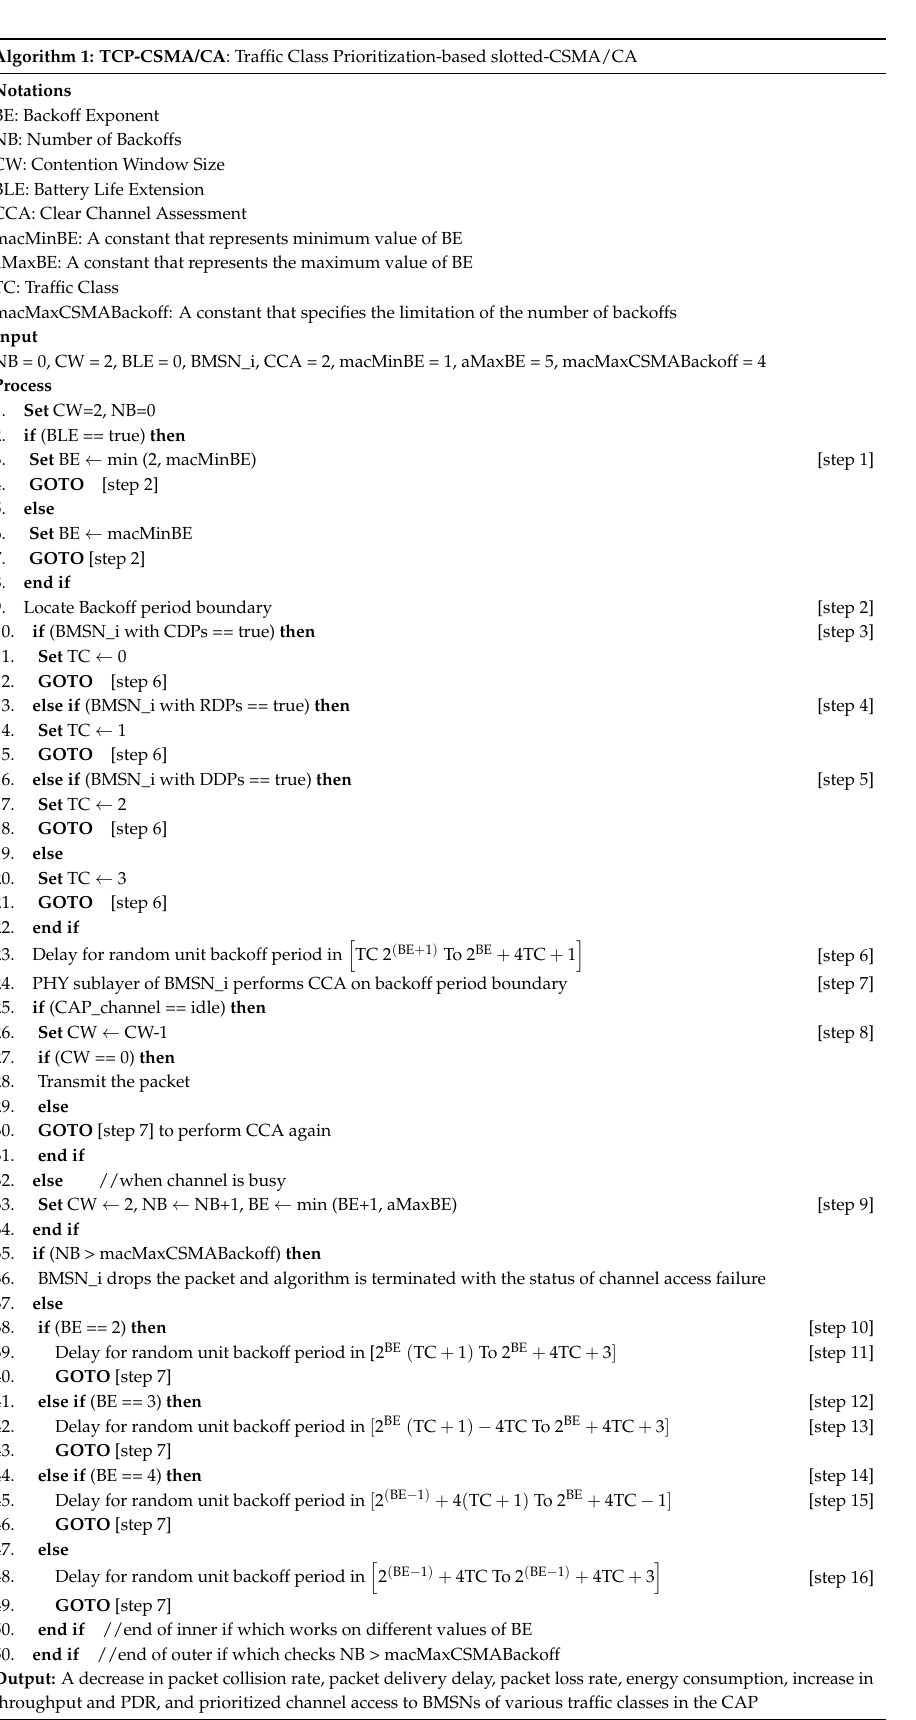
Algorithm 1: TCP-CSMA/CA : Traffic Class Prioritization-based slotted-CSMA/CA Notations BE: Backoff